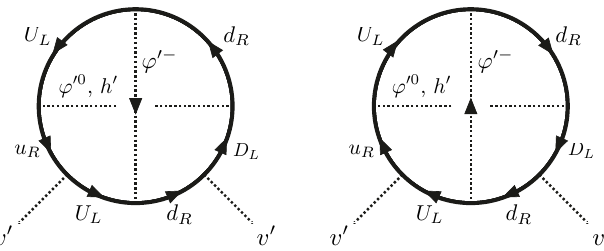
Figure 3. Diagrams that contribute to eq. (5.2) and have asymmetric structure in the loop function. The neutral scalar propagator corresponds to the neutral NG boson ϕ 0 0 and the neutral Higgs boson h 0